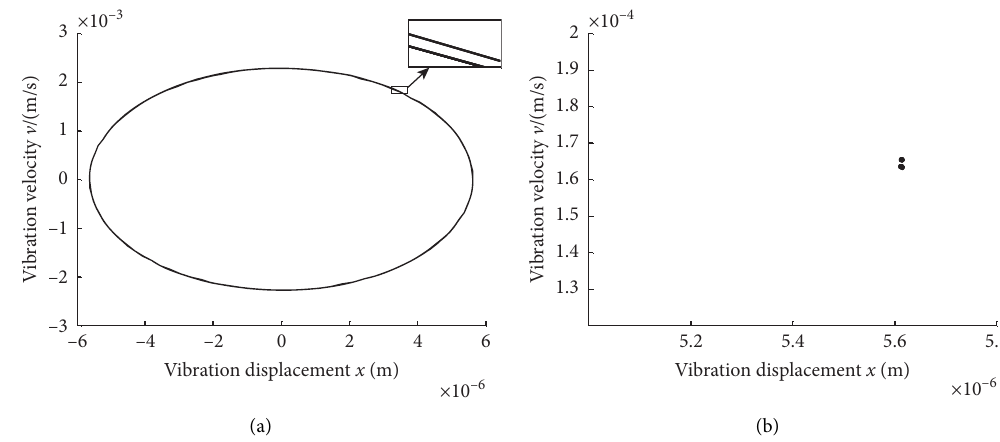
Figure 9: F � 6 . 012 × 10 5 N , 2-time cycle movement. (a) Phase trajectory diagram. (b) Poincar´e